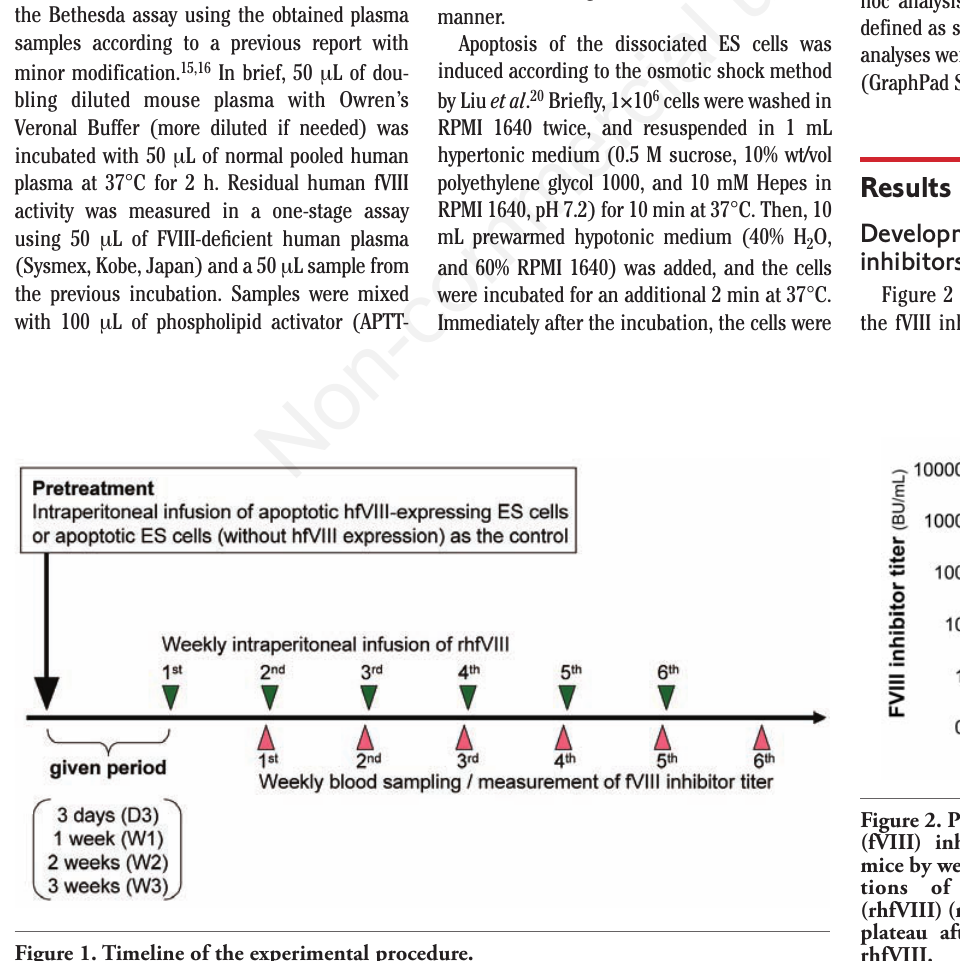
Figure 1. Timeline of the experimental procedure.